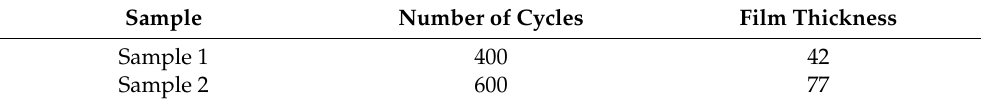
Table 1. Characteristics and designations of the obtained samples BFO/Polyimide.